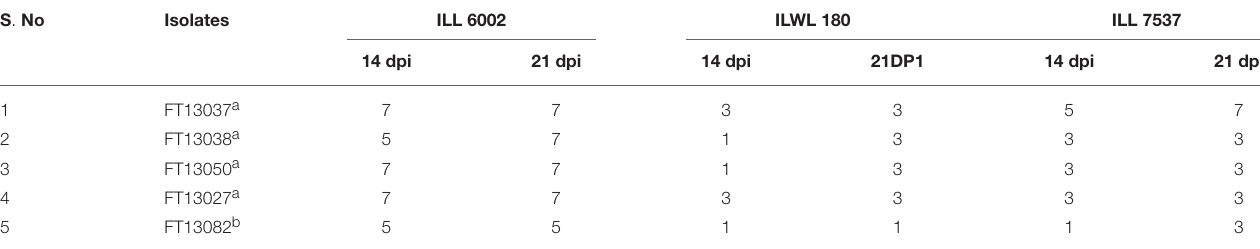
TABLE 4 | Modal disease scores of ILWL 180 and controls at 14 and 21 dpi against five A. lentis isolates S .